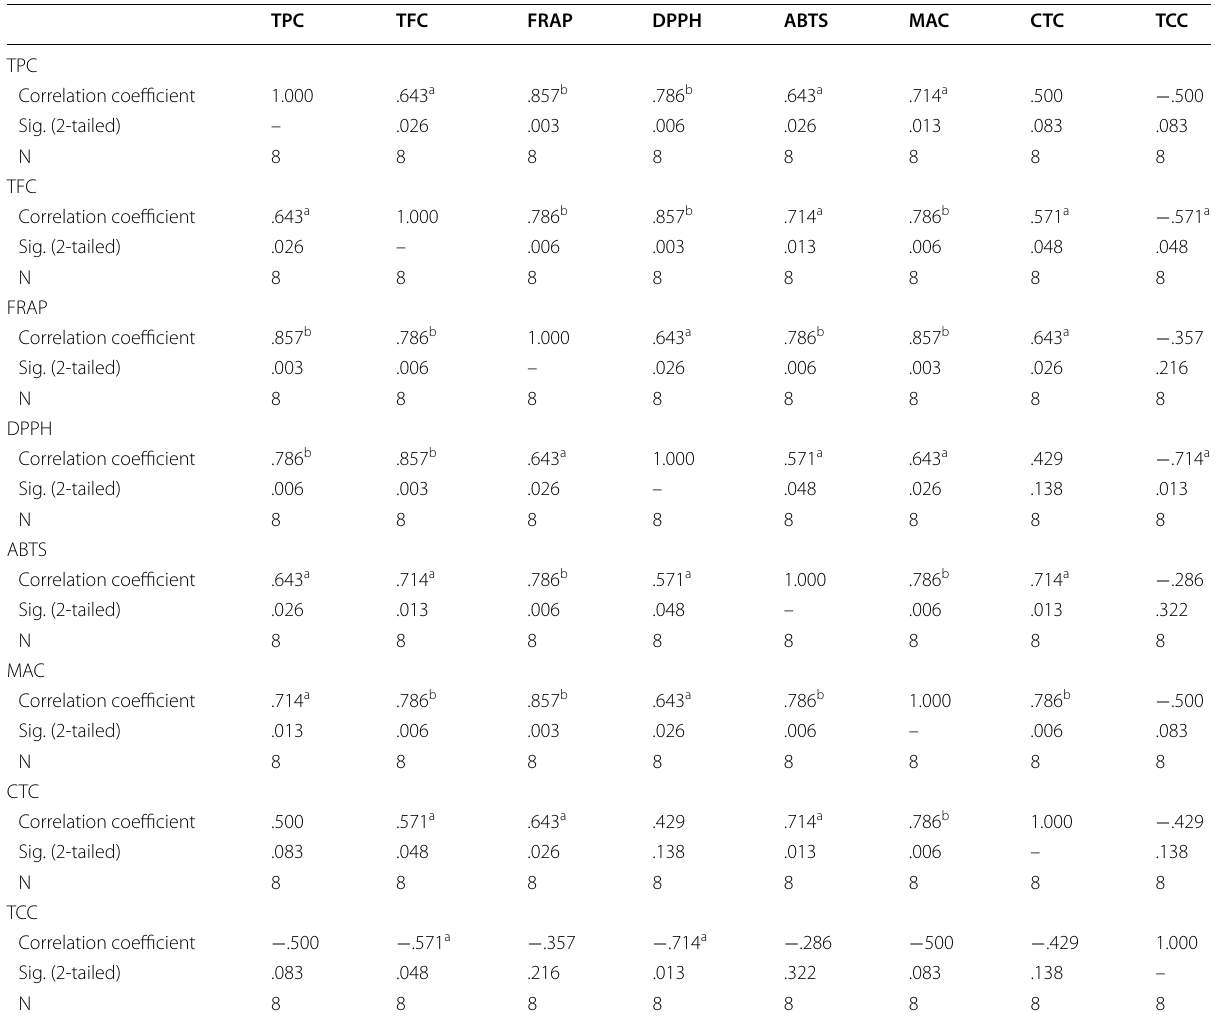
Table 5 Correlation analysis among the antioxidant, phenolics and